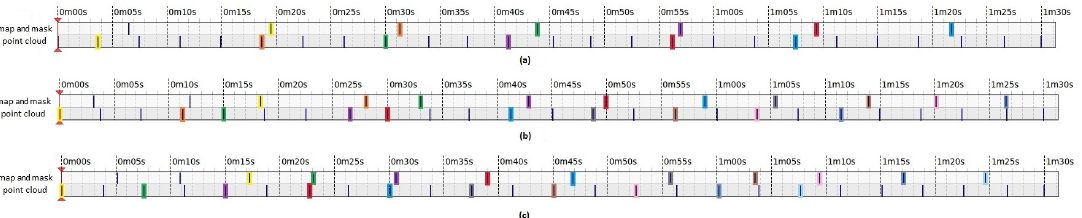
Figure 12. Output rate for the 3D point cloud, FEM and FRM using the last received 3D point cloud with one Map node ( a ), two Map nodes without forced spacing ( b ) and two Map nodes with one forced spacing ( c ).